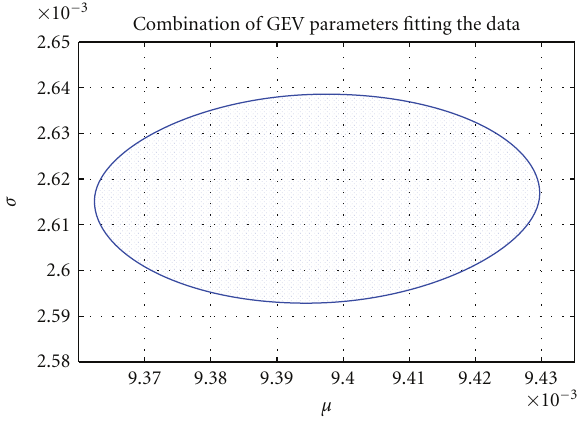
Figure 4: Region of GEV parameters leading to a PDF modeling the data set.